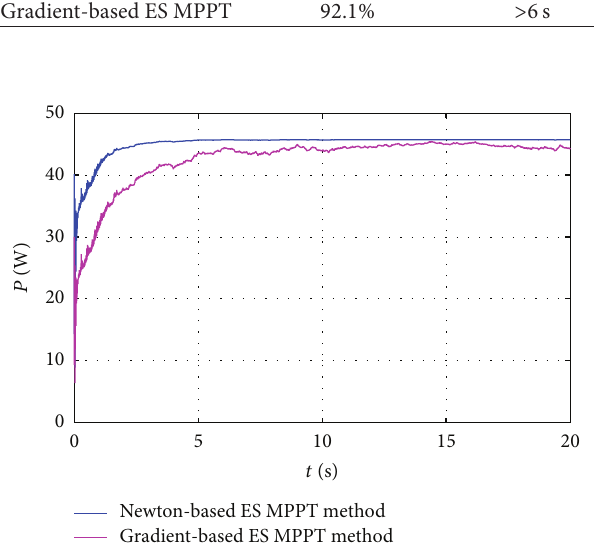
Figure 12: The comparison between the proposed MPPT method and classical extremum seeking MPPT